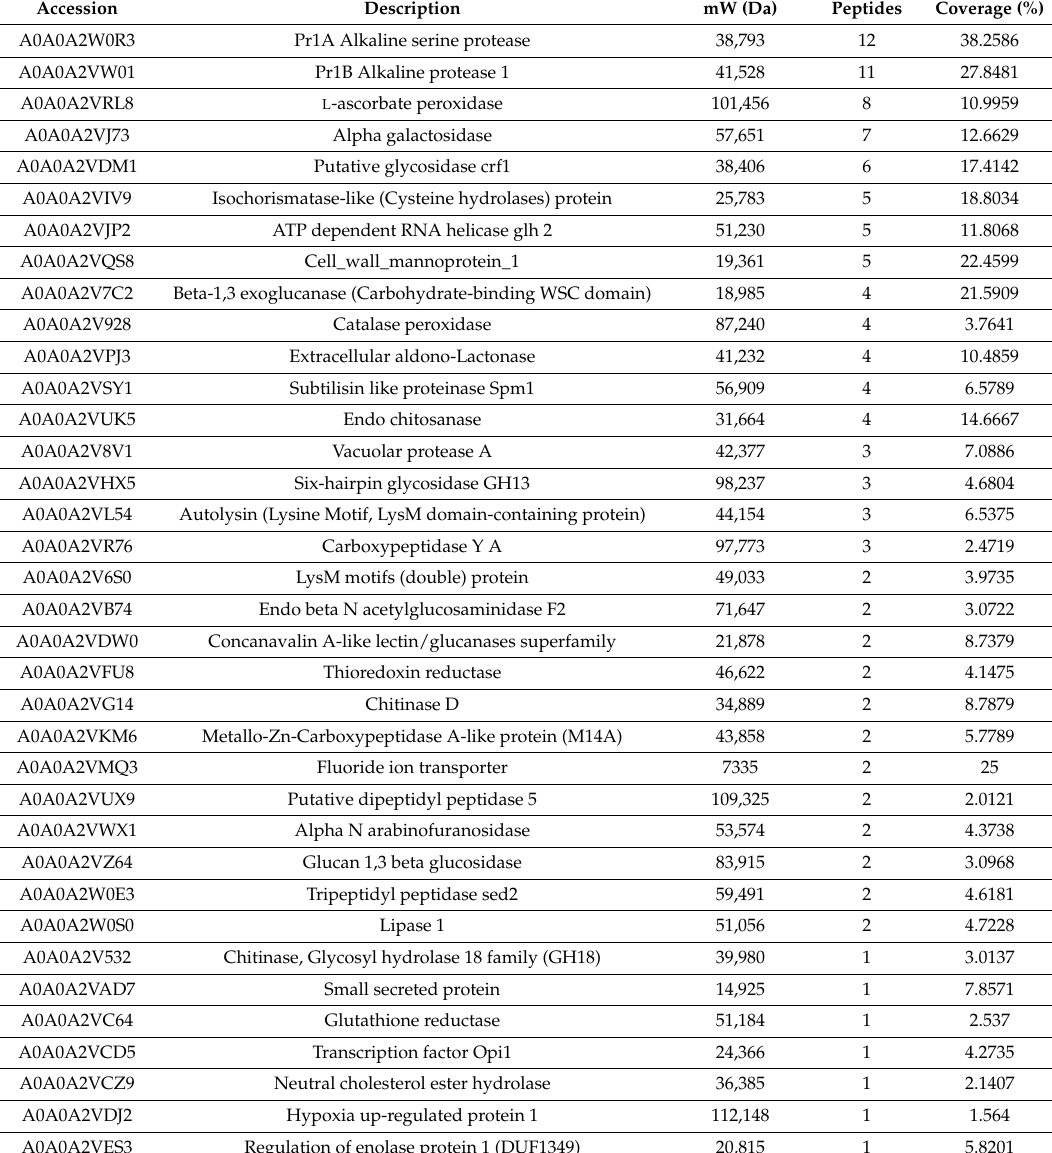
Table 1. Qualitative proteomics identification of B. bassiana exoenzymes/proteins present on day four in the supernatant of isolate 813 grown in the presence of intact cockroaches. Protein hits were ordered based on their peptide number and abundance (spectral counting) as obtained by PLGS 2.5 software (Waters, Milford, MA, USA). Annotation from Uniprot website cross-checked within several protein domain database websites (InterPro, https://www.ebi.ac.uk/interpro/;